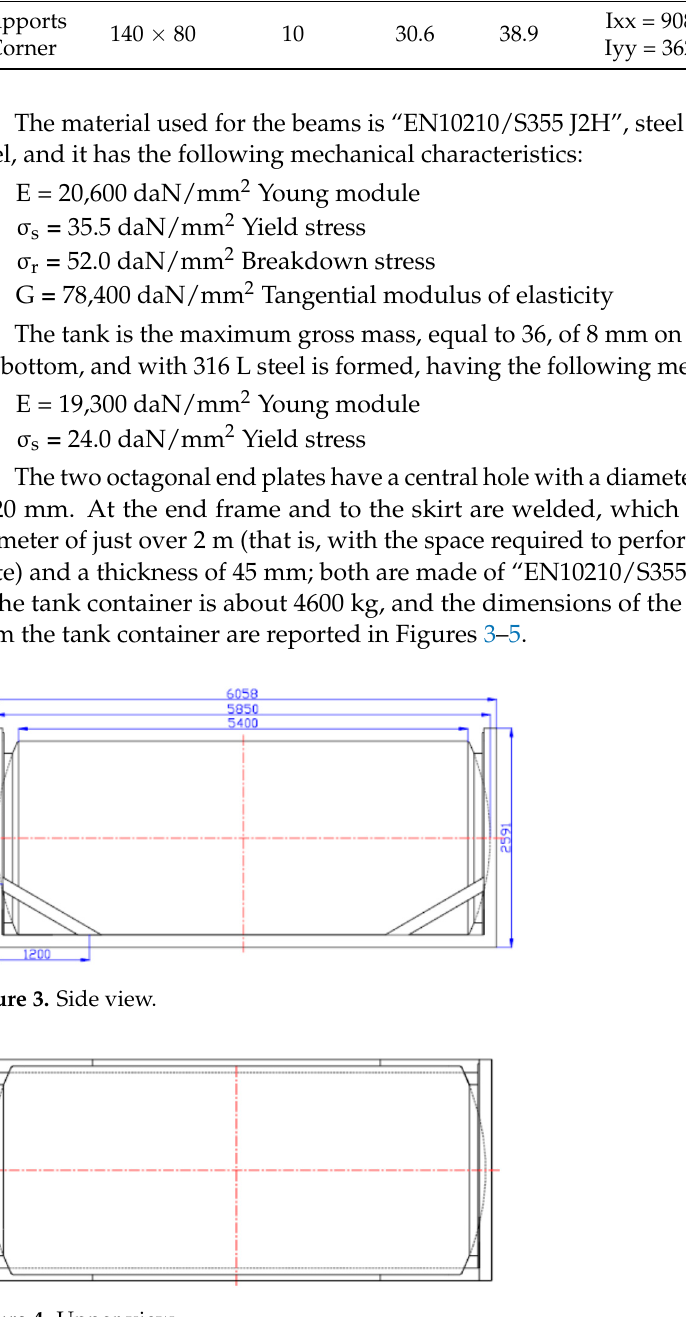
Figure 5. Front view. Realized the FEM model of the tank container and knowing the mode of application of the loads according to “ISO 1496-3: 1995 (E), section 6.2–6.13”, each of the tests de- scribed above was simulated, and the results were compared with the real values availa- ble, kindly provided by CAIB. Further, we used a safety coefficient of 1.5 for the stresses. It gave us the allowable stress of the two steels used, for the values indicated in Table 6. Table 6. Yield and allowable stress of the two types of steel used. Element